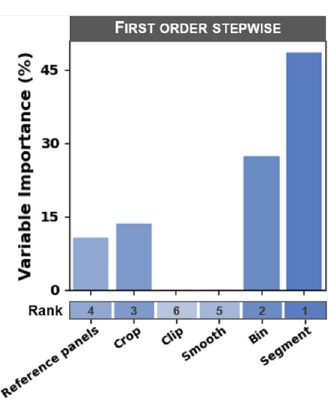
Figure 5. First- and total-order sensitivity index values for each of the six image processing steps calculated using both the Fourier amplitude sensitivity test (FAST) and Sobol methods. The sensitivity index at each step was ranked from most to least senstive and is indicated below the bar plots and with the corresponding color shades (note that higher ranks are denoted by smaller numeric values).